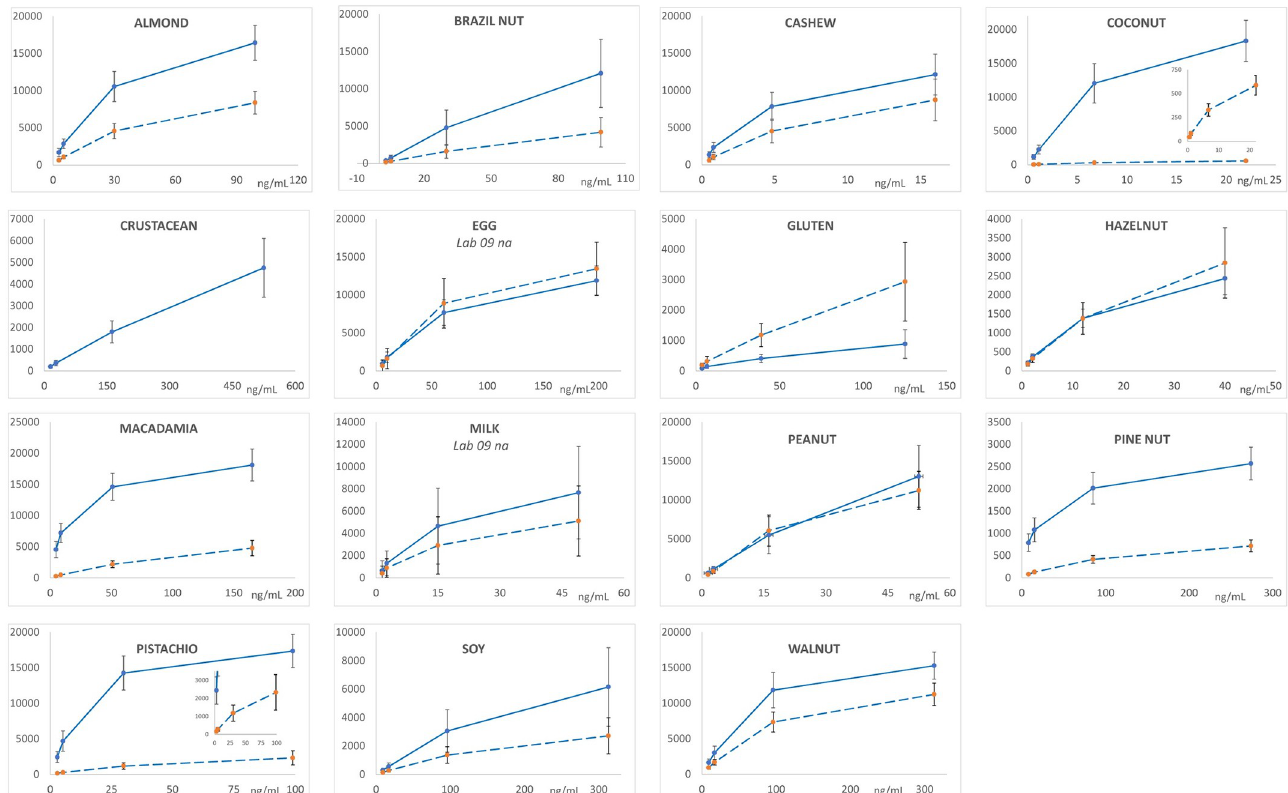
Fig 1. Calibration standards prepared in PBST. Plots of the calibration curves for each bead set, grouped by complementary pairs, for the average across all participating labs from an individual experiment using PBST as the solvent to prepare the calibration standards. The average MFI intensities were plotted as a function of the concentration of analyte in the calibration standards. The first numerical bead set of a complementary pair (i.e., almond-12, Brazil nut-14, cashew- 18, coconut-20, egg-25, gluten-27, hazelnut-29, macadamia-33, milk-35, peanut-37, pine nut-39, pistachio-43, soy-45, and walnut-47) represented by solid lines ( _______ ) and the complementary bead sets (almond-13, Brazil nut-15, cashew-19, coconut-21, egg-26, gluten-28, hazelnut-30, macadamia-34, milk-36, peanut-38, pine nut-42, pistachio-44, soy-46, and walnut-48) by dashed lines (- - - -). The MFI intensities averaged across the 11 laboratories were the values after subtracting the background (S0) with the error bars representing one standard